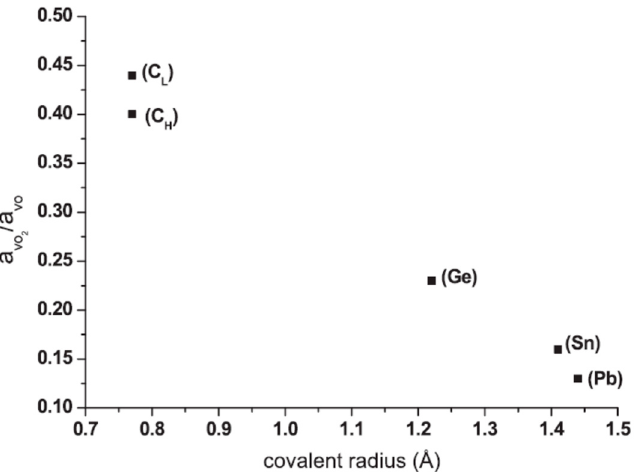
Figure 4. The conversion ratio a VO2/ a VO of the VO to VO 2 defect as a function of the isovalent dopant covalent radius Reproduced with permission from [143]. American Institute of Physics 2012.